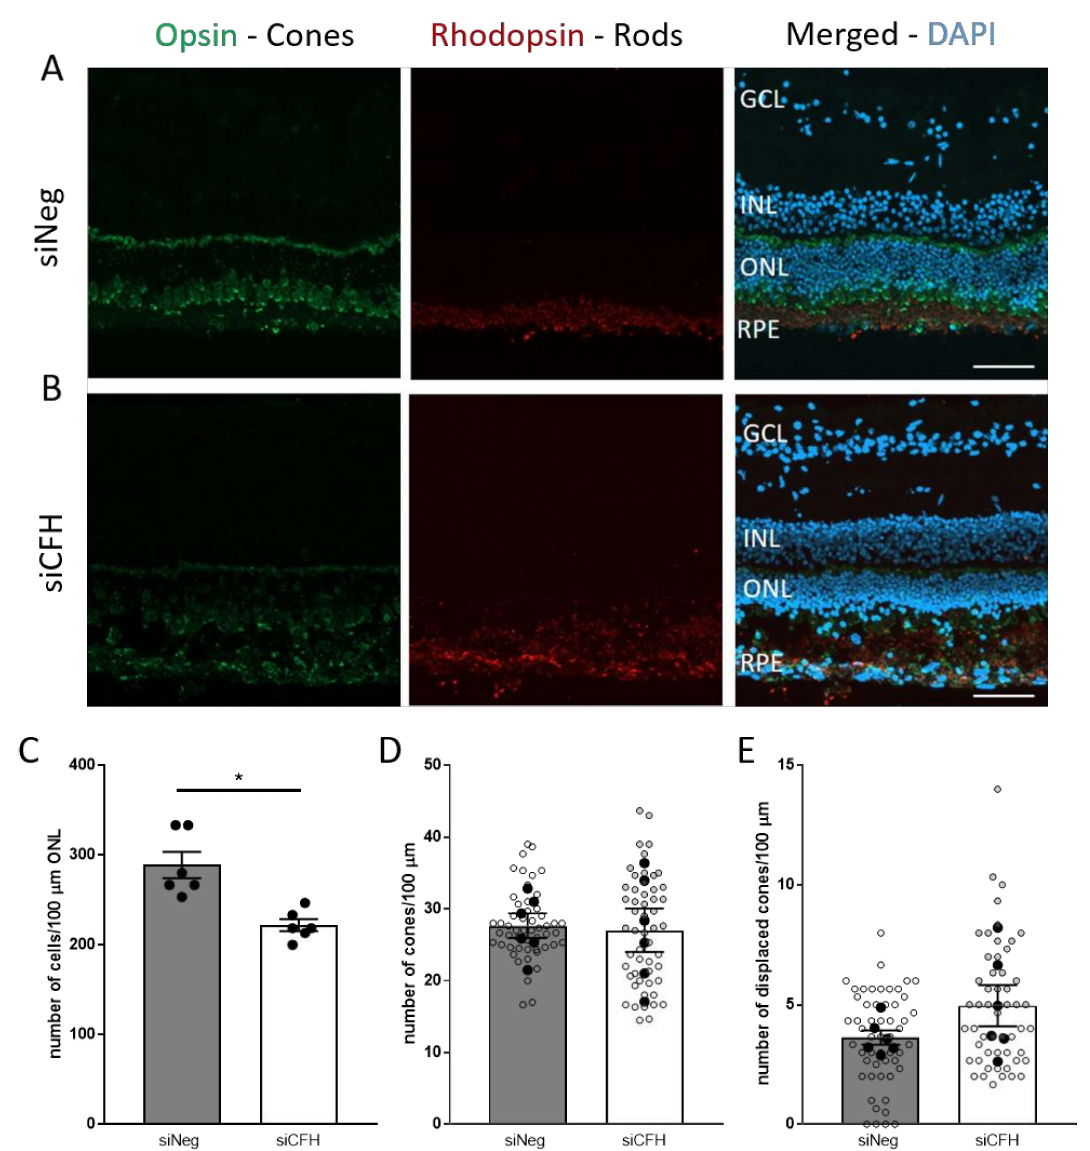
Figure 2. Effect of FH loss in RPE cells on porcine PR in co-culture. ( A , B ) Retinal explants from the visual streak of porcine donor eyes are exposed to either siNeg ( A ) or siCFH ( B ) hTERT-RPE1 cells for 72 h. Explants cryosections were stained for Opsin (green) and Rhodopsin (red) to differentiate between cones and rods, and DAPI was used as counterstaining for nuclei. ( C – E ) Quantification of retinal parameters extrapolated from A-B: number of cells in ONL ( C ), number of cones in ONL ( D ) and number of displaced coned ( E ). Abbreviations: GCL—Ganglion cell layer, INL—inner nuclear layer, ONL—outer nuclear layer, RPE—retinal pigmented epithelium cells, siNeg—silencing negative control, si CFH —silencing CFH . Mean ± SEM is shown. N = 6 biological replicates. * p ≤ 0.05. Scale bar—50 µ